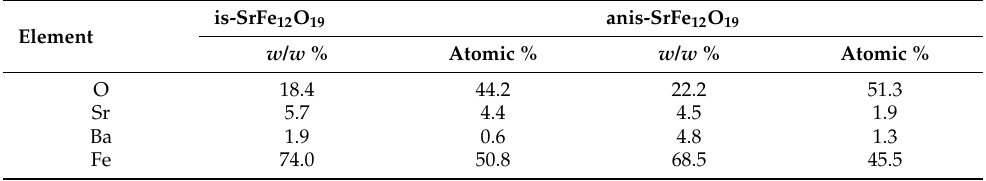
Table 4. Composition of the is-SrFe 12 O 19 and anis-SrFe 12 O 19 powders. The data were obtained by EDX determinations and represent the average of five measurements on different